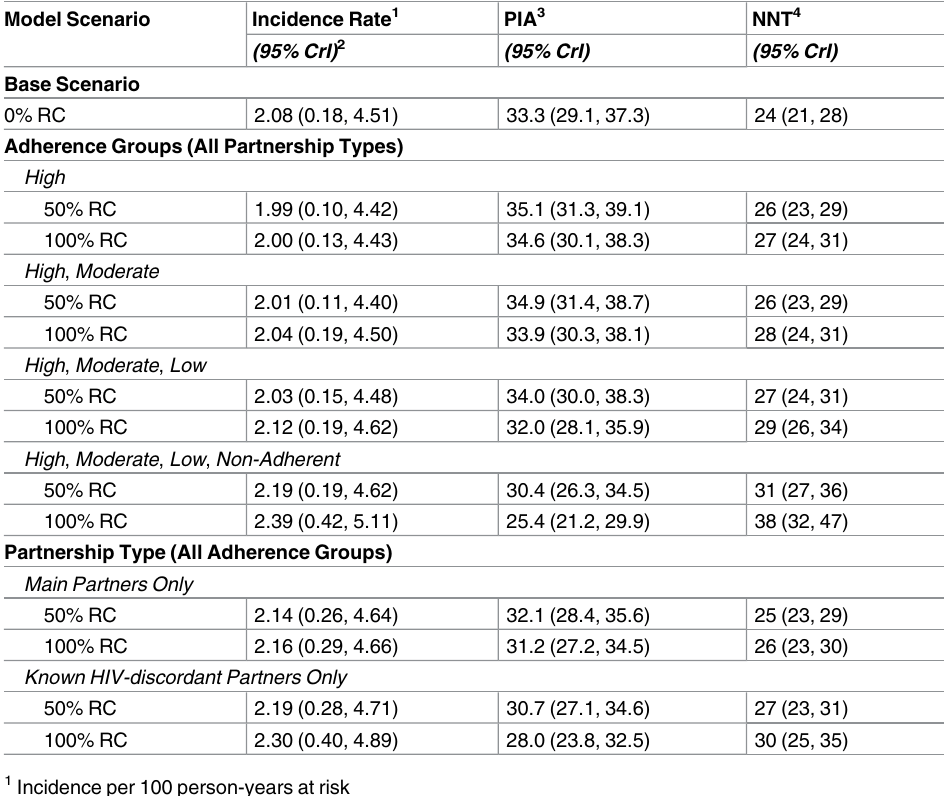
Table 1. HIV Incidence Rate, Percent of Infections Averted, and Number Needed to Treat by Risk Com- pensation Level, by PrEP Adherence Level and Partnership Types, among US MSM. Model